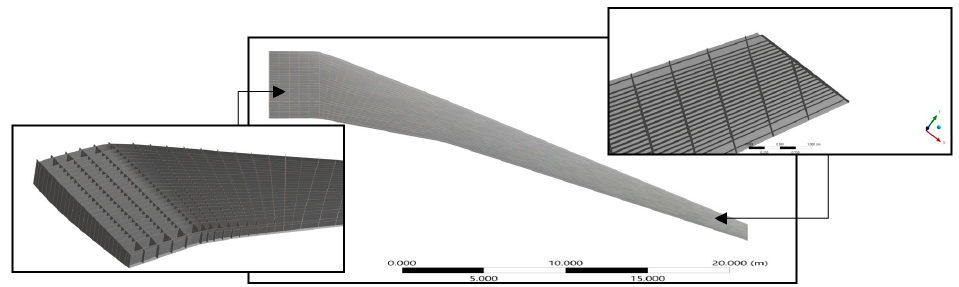
Figure 5. CRM aircraft: FEM model used for the aero-structural (FSI) computations.